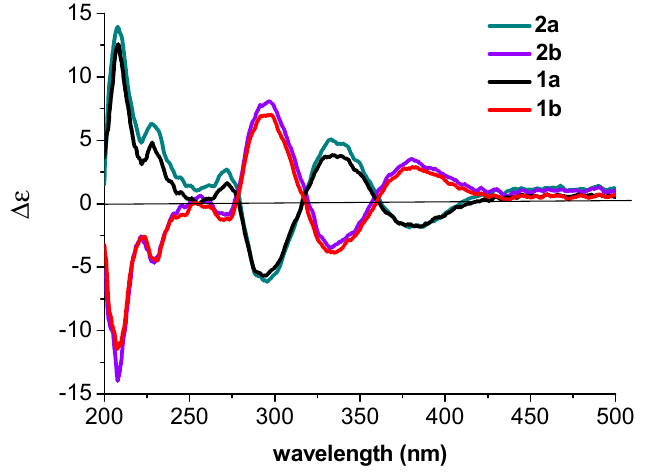
Figure 5. The experimental ECD spectra of 2a , 2b , 1a , and 1b .